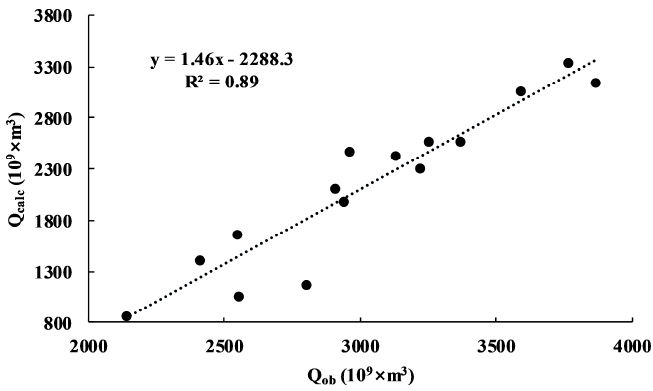
Figure 2. Relation between observed runoff Q ob and runoff calculated from water balance equation Q calc .